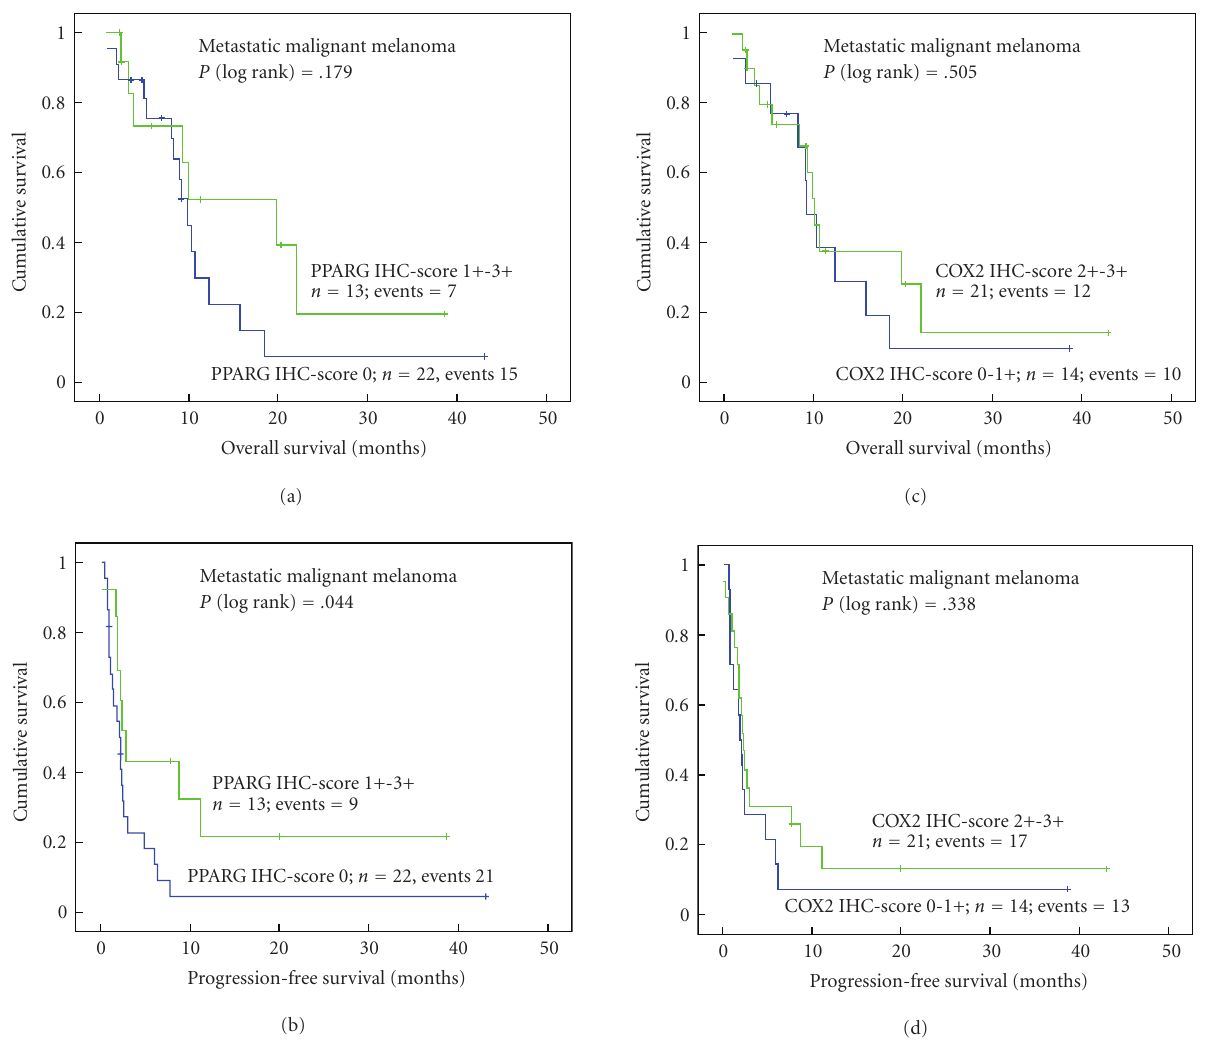
Figure 4: Distribution of time (months) to death and tumor progression among patients with advanced metastatic melanomas in correlation with immunoreactivity of PPARG (a), (b) or COX2 (c), (d). All patients received biomodulatory treatment. The calculation was performed according to the method of Kaplan and